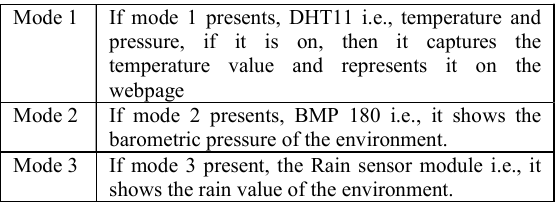
Table 1. Multiple modes in weather monitoring System